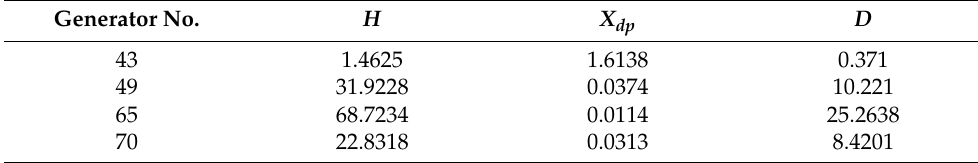
Table 3. Dynamic parameters of the newly added fictitious generators (machine base: 100 MVA). Generator No. H